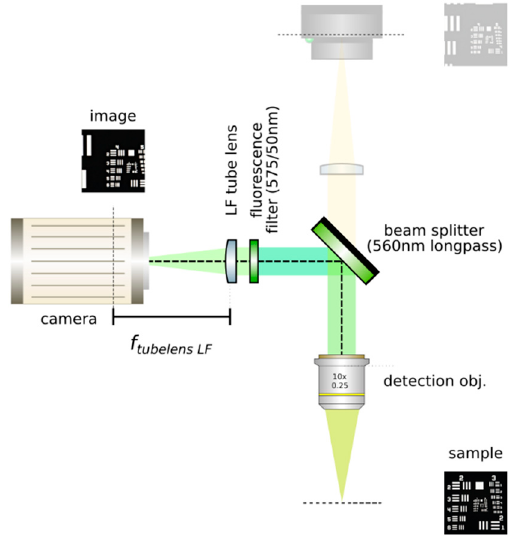
Figure 13. Place a second camera and acquire a reference image. Place a camera after the LF tube lens, making sure to obtain a sharp image of the same portion of the sample such as that seen on the orthographic camera. Do not displace the sample. Acquire a reference image and measure the sample. Use this image to ensure magnification when inserting the relay pair.